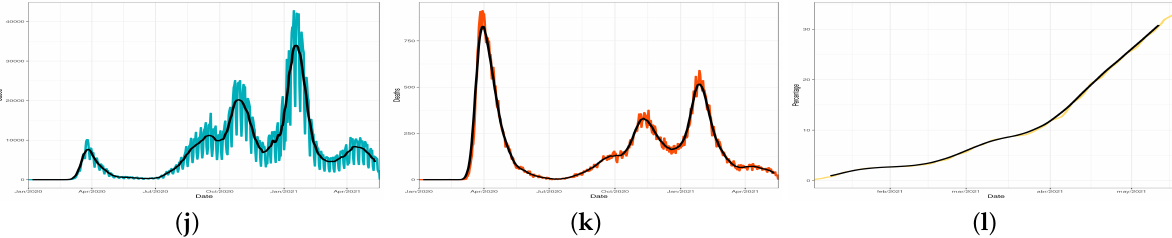
Figure 1. Confirmed cases, deaths, and vaccinated people per hundred individuals: ( a ) Chile cases; ( b ) Chile deaths; ( c ) Chile vaccines; ( d ) Mexico cases; ( e ) Mexico deaths; ( f ) Mexico vaccines; ( g ) Peru cases; ( h ) Peru deaths; ( i ) Peru vaccines; ( j ) Spain cases; ( k ) Spain deaths; and ( l ) Spain vaccines .